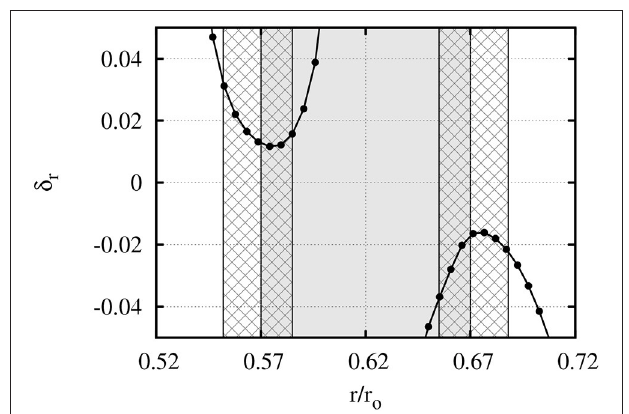
FIGURE 9 | Mean penetration depth along radius for model 4.10. The gray shaded area marks the SSL; the hatched areas indicate the radius range in which the extrema of δ r are